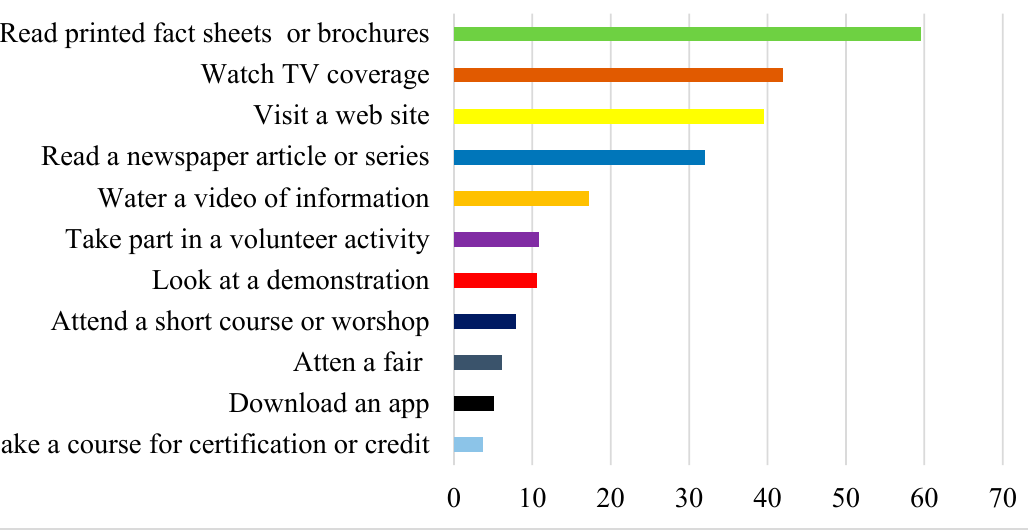
Figure 2. Percent of responses about preference for learning opportunities about water issues.